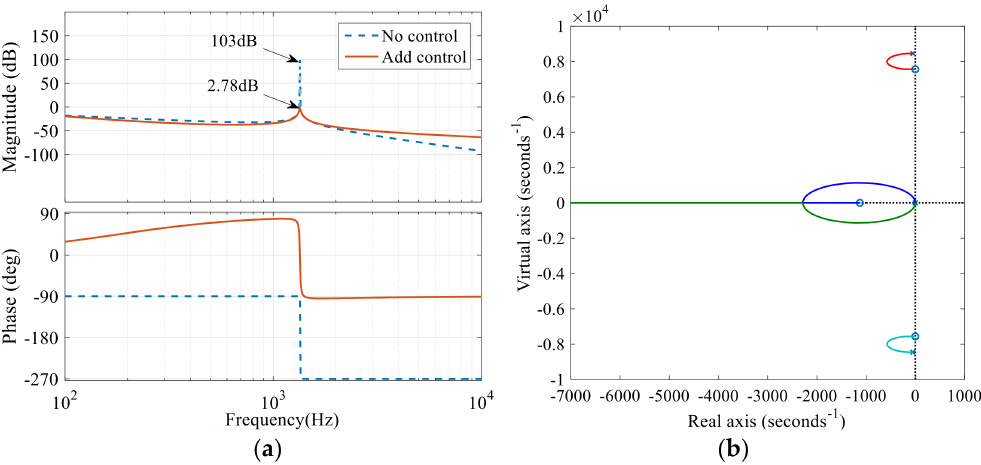
Figure 6. ( a ) Capacitor current feedforward and inverter-side current feedback control frequency characteristic curve; ( b ) Root